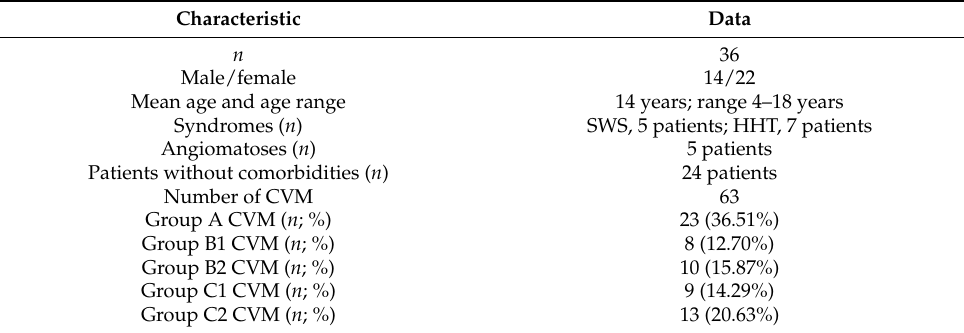
Table 2. Characteristics of the Study